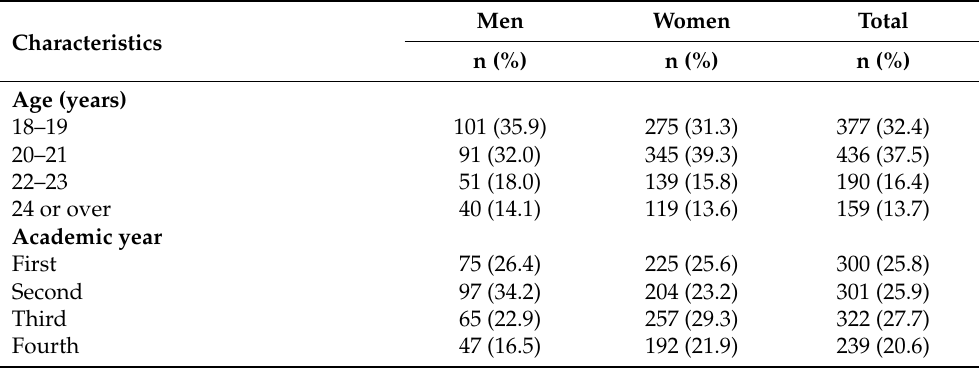
Table 1. Characteristics of study